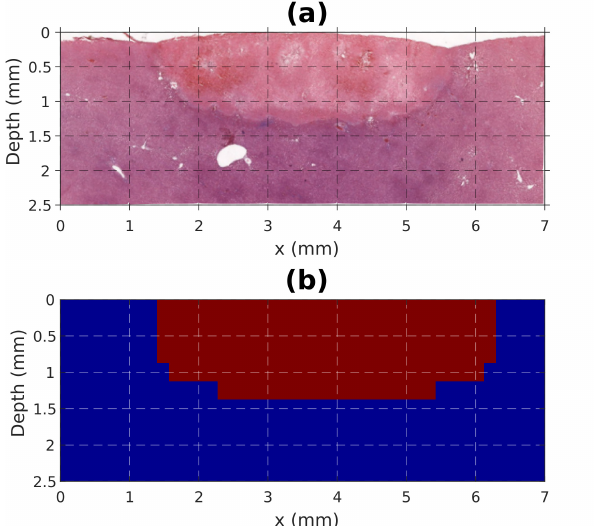
Figure 5. ( a ) Histological H&E stained slide image for rat liver and ( b ) the necrotic profile obtained from the mathematical model, considering a light fluence rate of 75 mW/cm 2 , a light dose of 150 J/cm 2 , and a threshold dose of 950 µ M for [ ROS ]